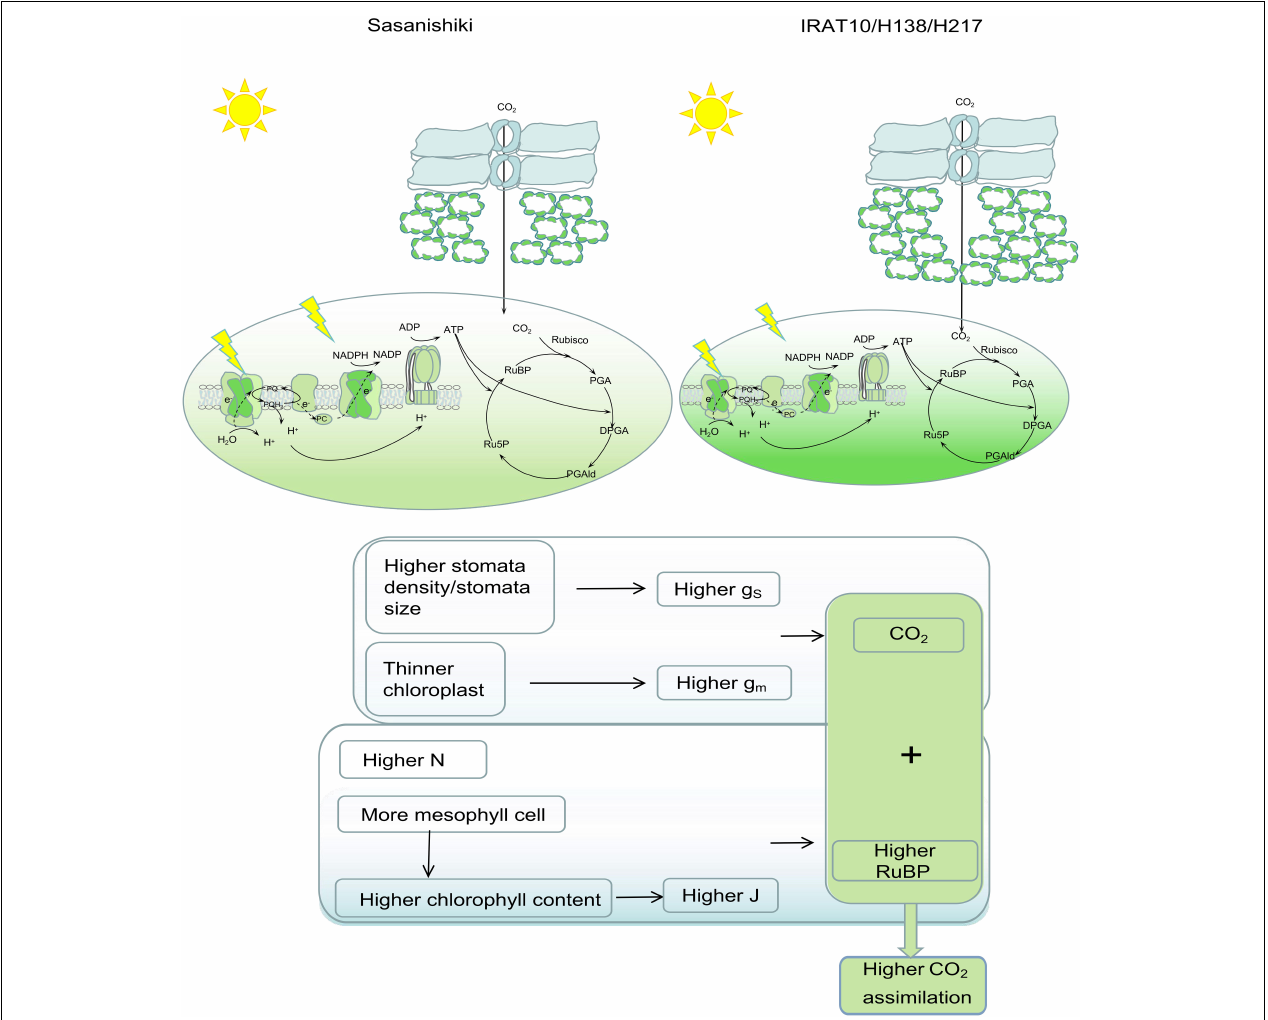
FIGURE 8 | Leaf anatomy, photochemical, and biochemical traits contribute to photosynthetic differences between Sasanishiki and IRAT10, H138, and H217. Higher stomatal density/size together with thinner chloroplast contributed to higher CO 2 concentration at the carboxylation set. More mesophyll cells, higher content, and higher chlorophyll content contributed to a higher electron transport rate, which facilitates RuBP circulation. Higher CO 2 concentration together with higher RuBP content contributed to a higher